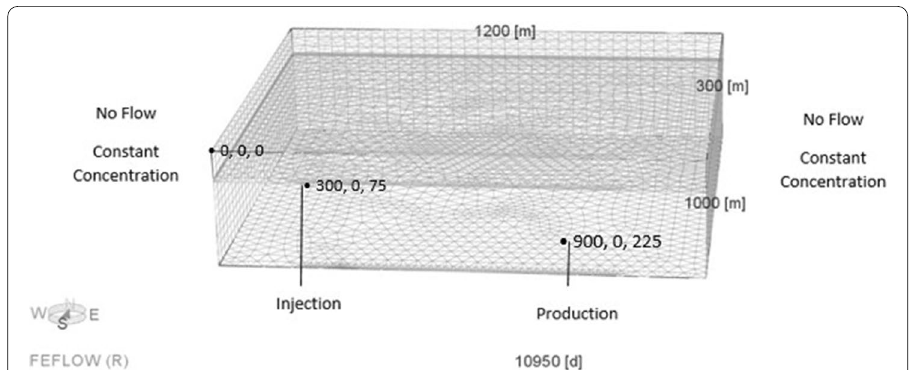
Fig. 3 3-D model domain and boundaries for a binary geothermal